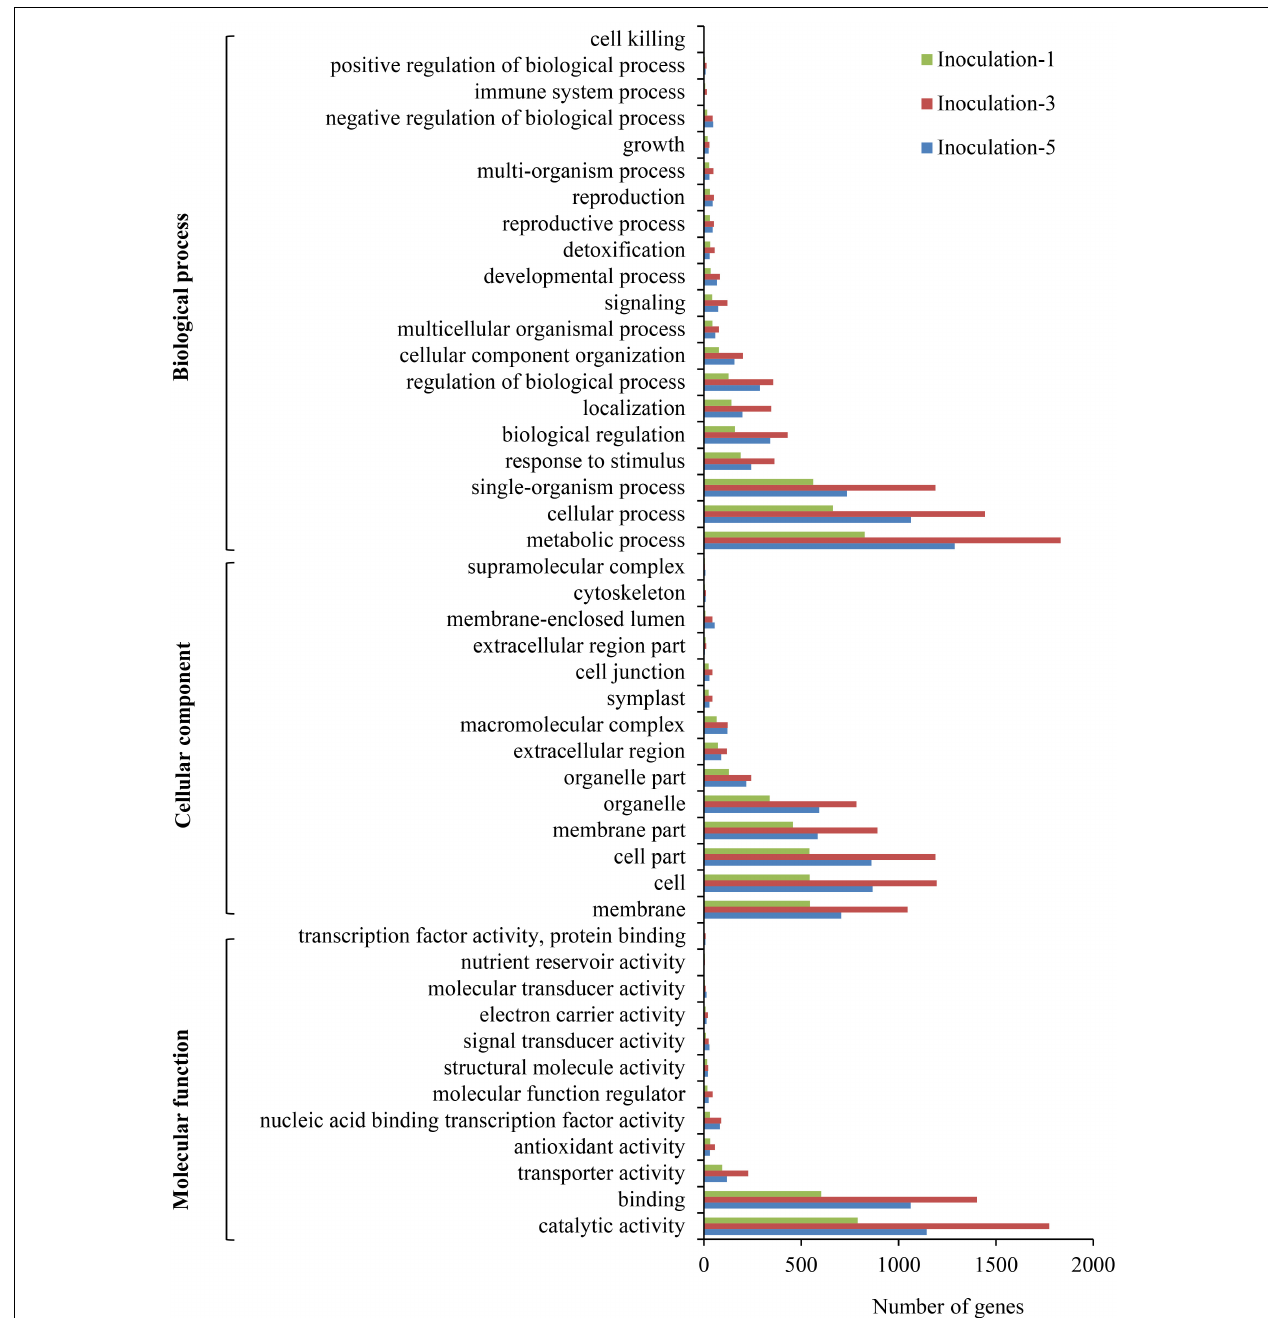
FIGURE 6 | Pathway functional enrichment of differentially expressed genes. Inoculation-1, -3, and -5 represent inoculation treatments on the 1st, 3rd, and 5th day, respectively.